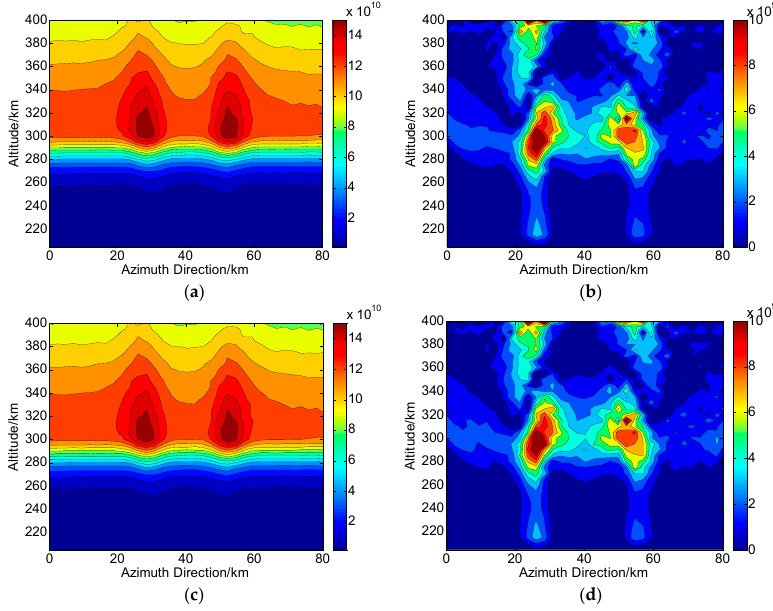
Figure 9. Two-dimensional CIT reconstructions under the condition of channel phase imbalance ( 5 ° ) in Changbai. ( a , c ) are the reconstructed results based on F Ω and BB Ω , respectively. ( b , d ) are the